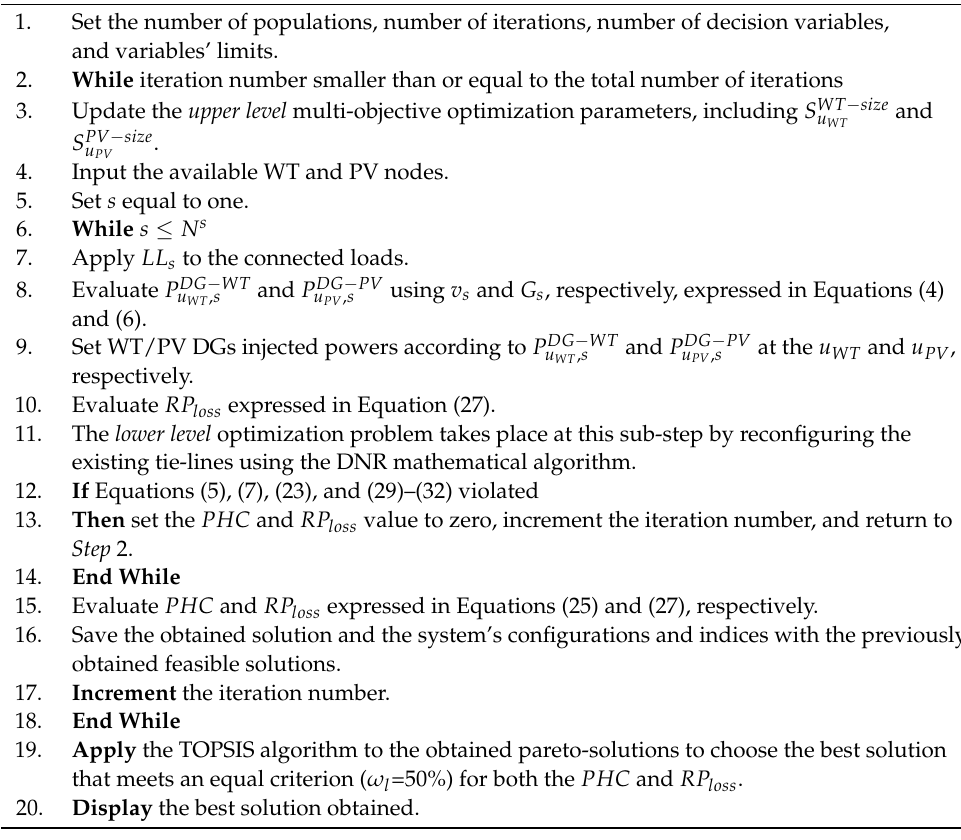
Algorithm 1 The proposed bilevel multi-objective optimization for HC